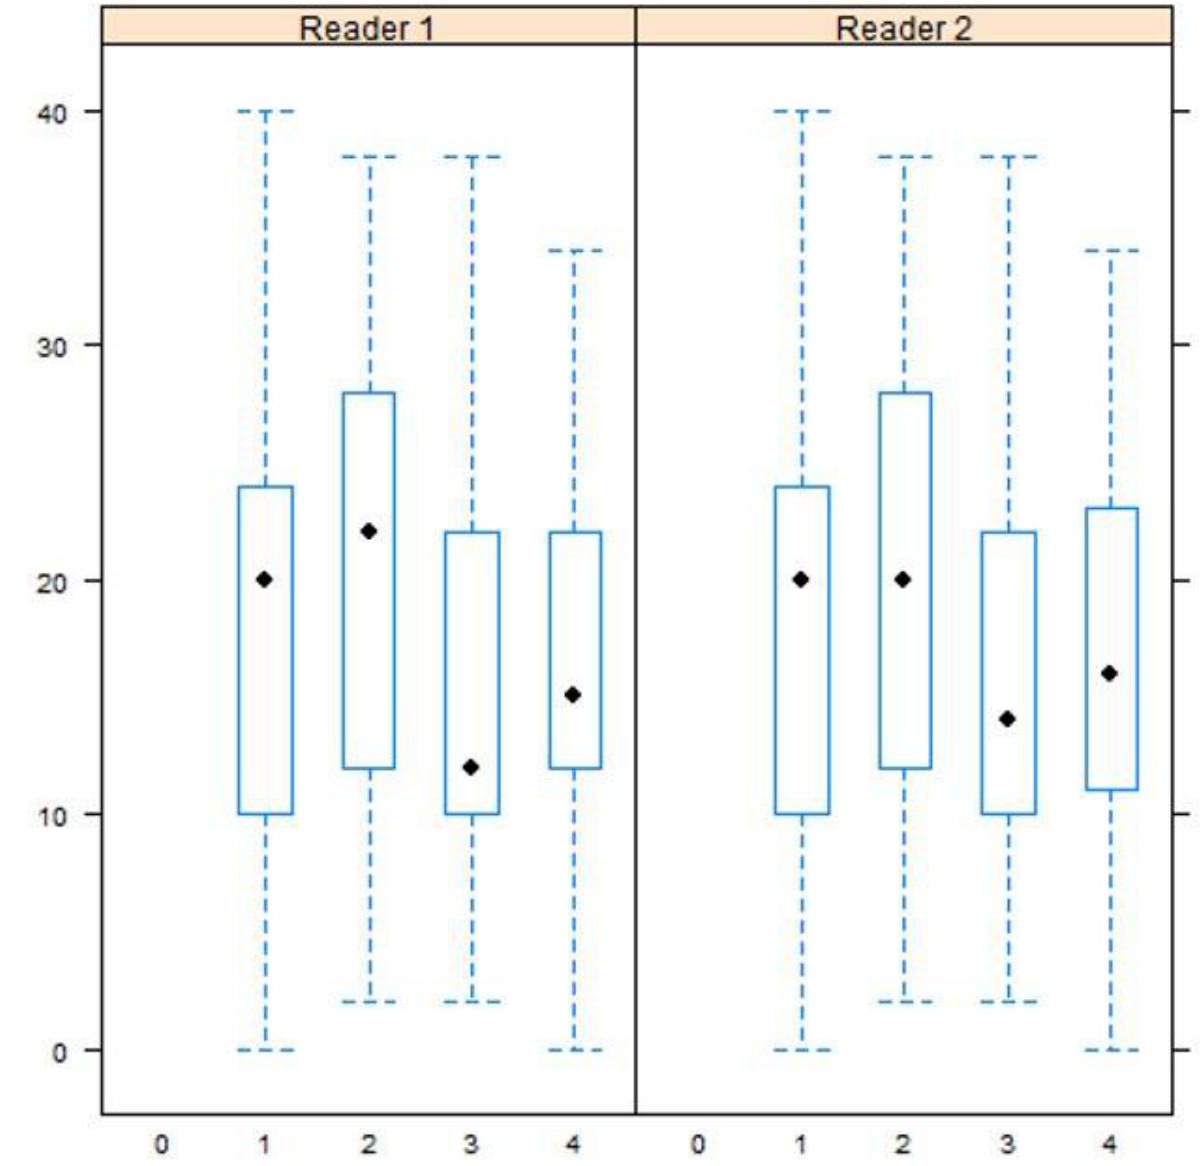
Figure 4. Box-plot showing mean mobility score ( y -axis) according to inferior glenohumeral ligament intensity grade ( x -axis) for reader 1 and reader 2.